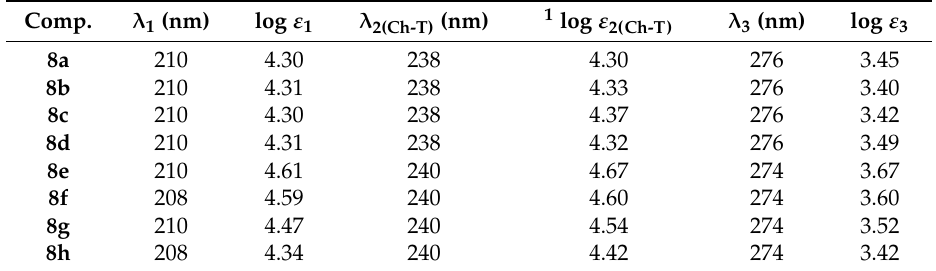
Table 3. Wavelengths of the observed absorption maxima ( λ 1 , λ 2(Ch-T) and λ 3 ) and logarithms of the molar absorption coefficients (log ε ) of compounds´ methanolic solutions ( c = 3.0 × 10 − 5 M), which were investigated in the UV/Vis region of a spectrum.